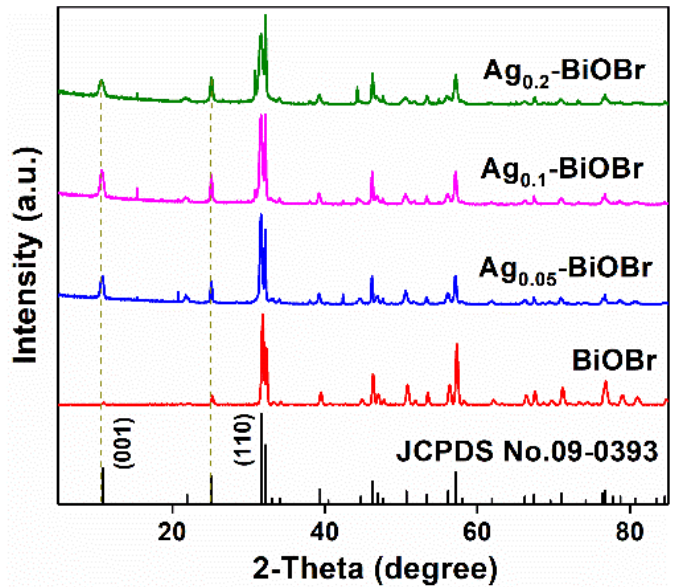
Figure 1. XRD patterns of BiOBr and Ag-BiOBr.